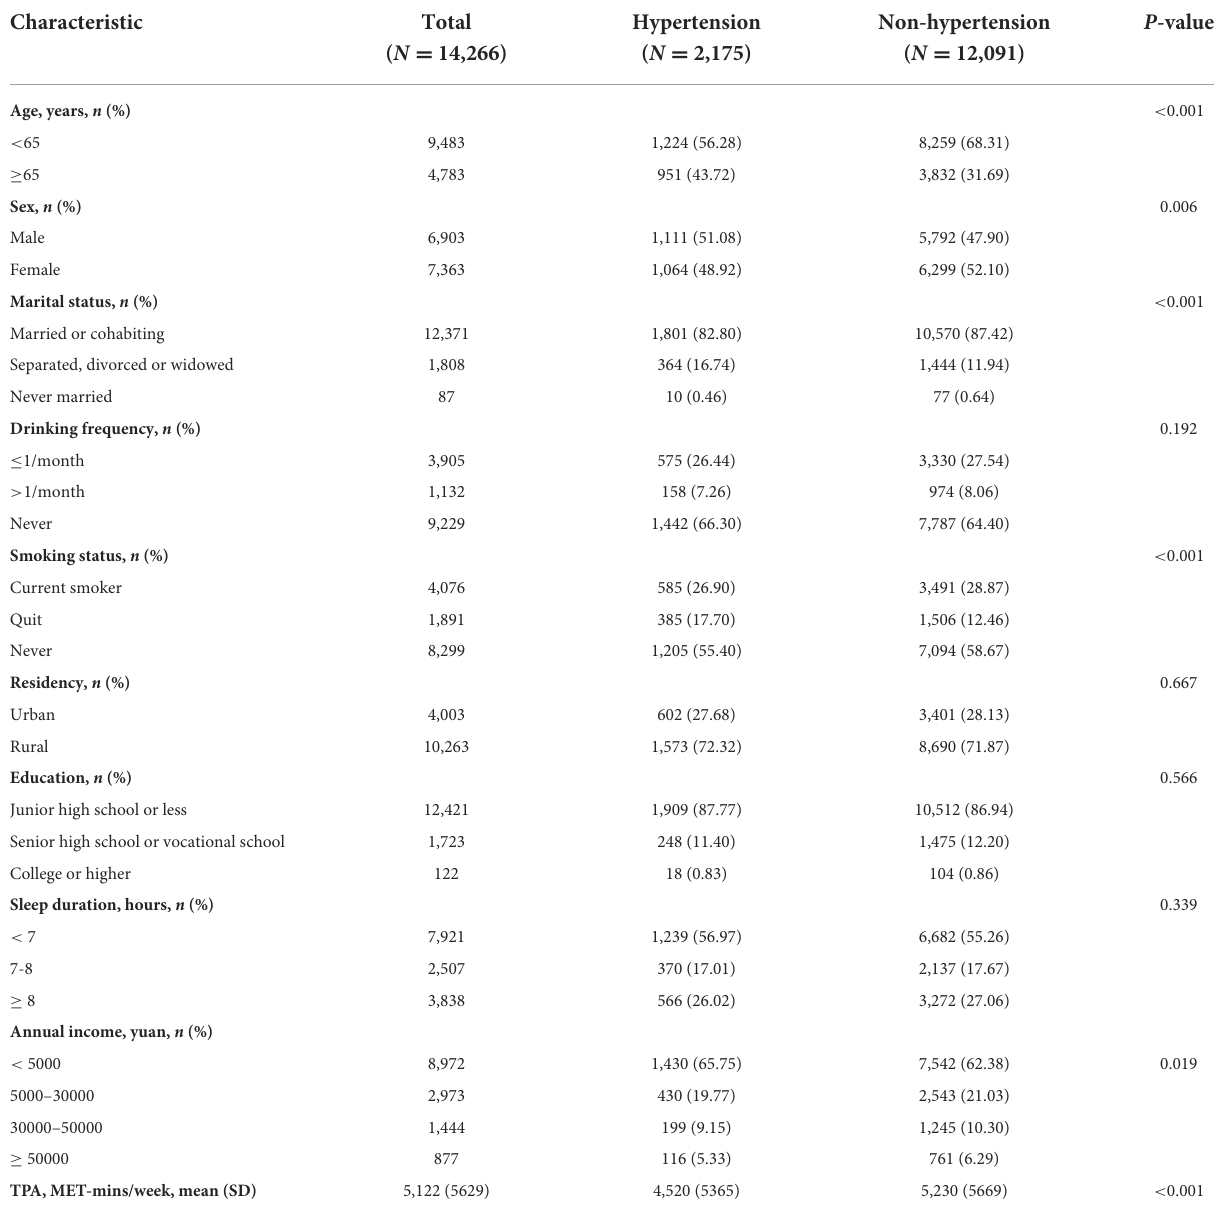
TABLE 1 Baseline characteristics of